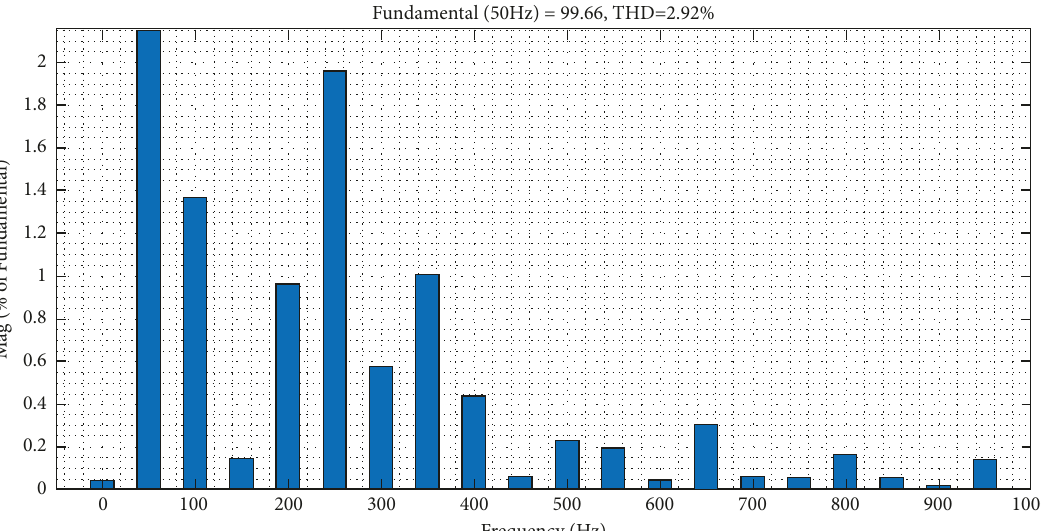
Figure 18: THD (current) for FIS with level shift PWM.